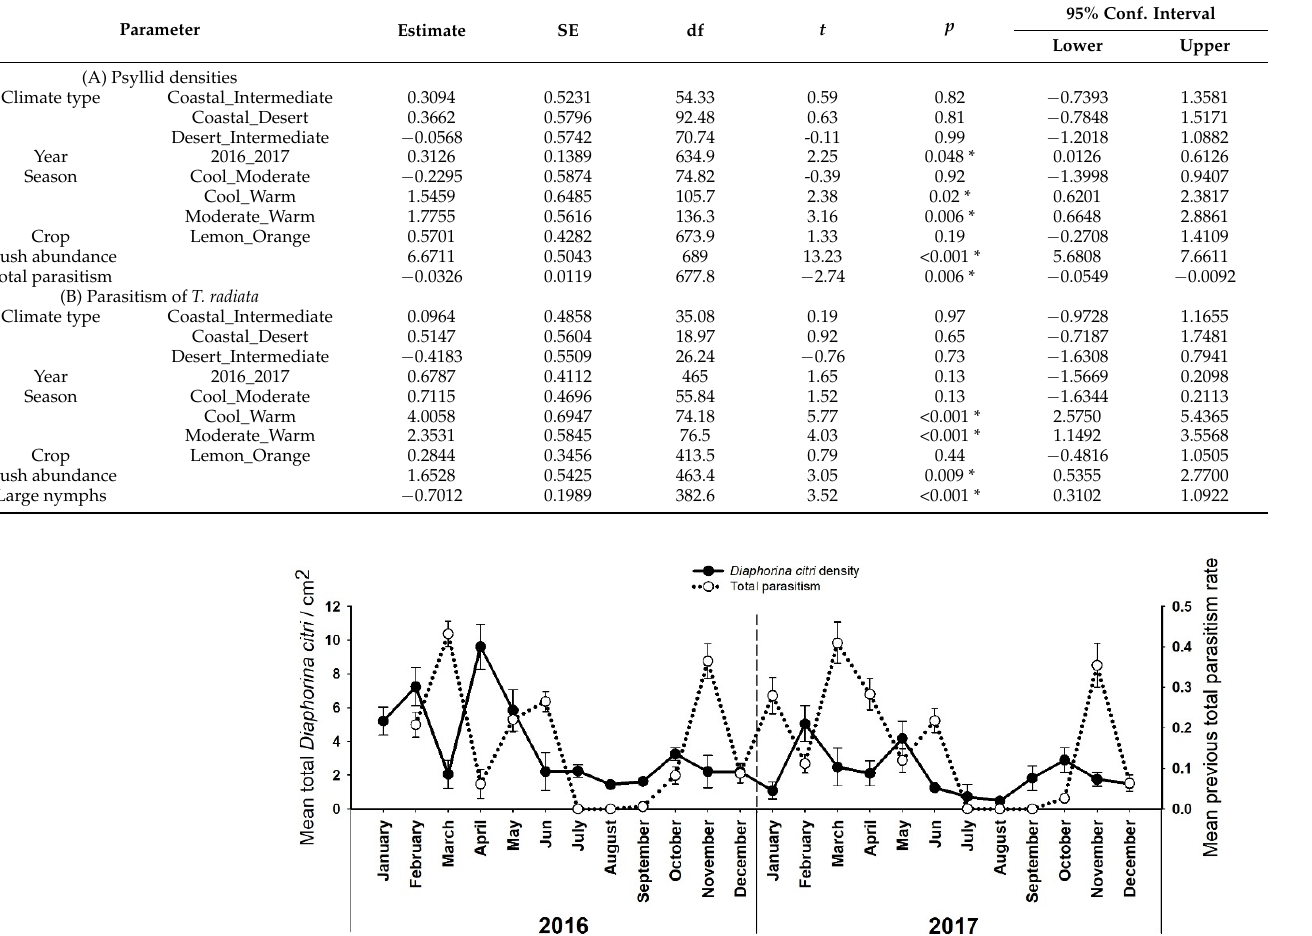
Table 2. Results of generalized linear mixed-effects models examining the main and interaction effects of climate type and host plants on recorded (A) total psyllid densities and (B) parasitism rates of T. radiata at field sites from January 2016 through December 2017. The selected regression model for psyllid abundance also included a covariate of total parasitism rates from the prior sampling period (A). The selected regression model for parasitism rates of T. radiata also included a covariate of densities of late fourth and fifth instar psyllid nymphs from the previous sampling period (B). The final minimal and most adequate regression models for each response variable are presented below. The critical level of significance was set at 0.05 *.